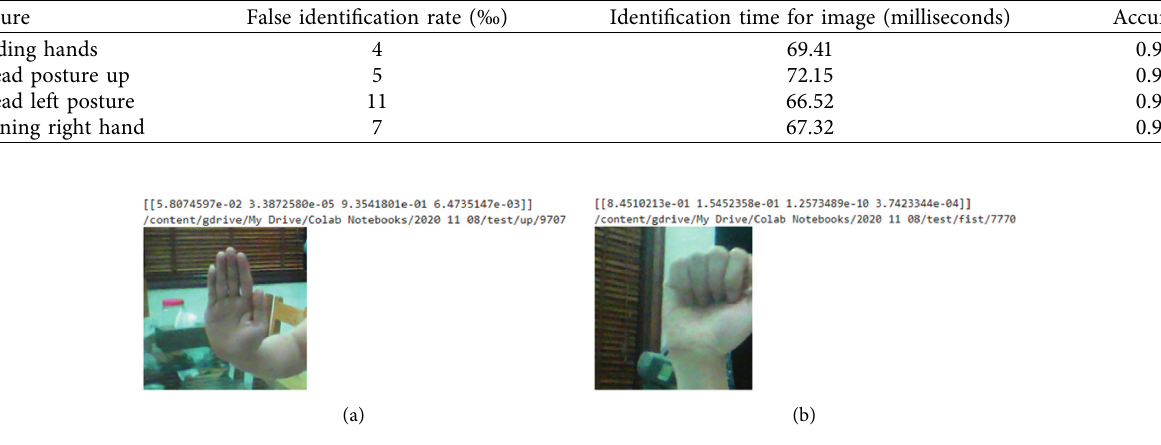
Figure 14: Result of false identification for (a) up and (b) toggle gestures. Table 5: Result of dynamic posture recognition for 30